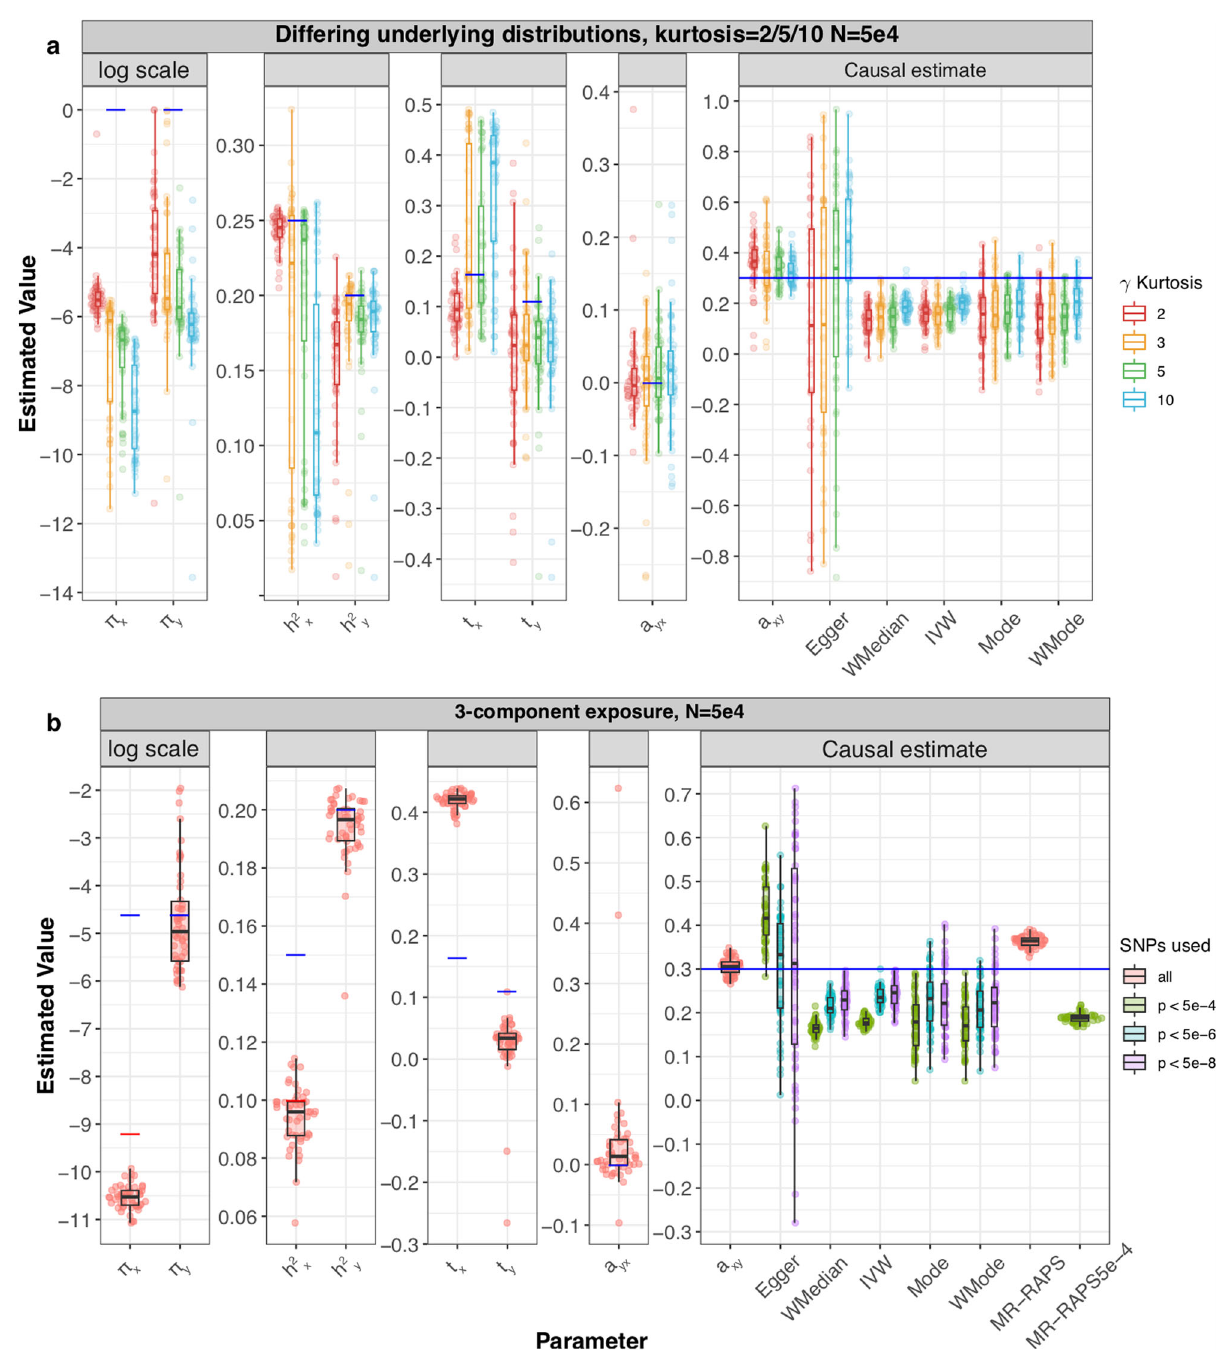
Fig. 3 Simulation results under various scenarios. These modi fi ed Sina-boxlots represent the distribution of parameter estimates from 50 different data generations under various conditions. For each generation, standard MR methods as well as our LHC-MR were used to estimate a causal effect. In the boxplots, the lower and upper hinges correspond to the fi rst and third quartiles, the middle bar corresponds to the median, whereas the upper whisker is the largest dataset estimate smaller than 1.5×inter-quartile range above the third quartile. The lower whisker is de fi ned analogously. The true values of the parameters used in the data generations are represented by the blue dots/lines. a The different coloured boxplots represent the underlying non-normal distribution used in the simulation of the three γ x , γ y , γ u vectors associated to their respective traits. The Pearson distributions had the same zero mean and skewness, however their kurtosis ranged between 2 and 10, including the kurtosis of 3, which corresponds to a normal distribution assumed by our model. The standard MR results reported had IVs selected with a p -value threshold of 5 × 10 − 6 . b Addition of a third component for exposure X , while decreasing the strength of U . True parameter values are in colour, blue and red for each component ( π x 1 ¼ 1 ´ 10 (cid:3) 4 ; π x 2 ¼ 1 ´ 10 (cid:3) 2 ; h 2 x